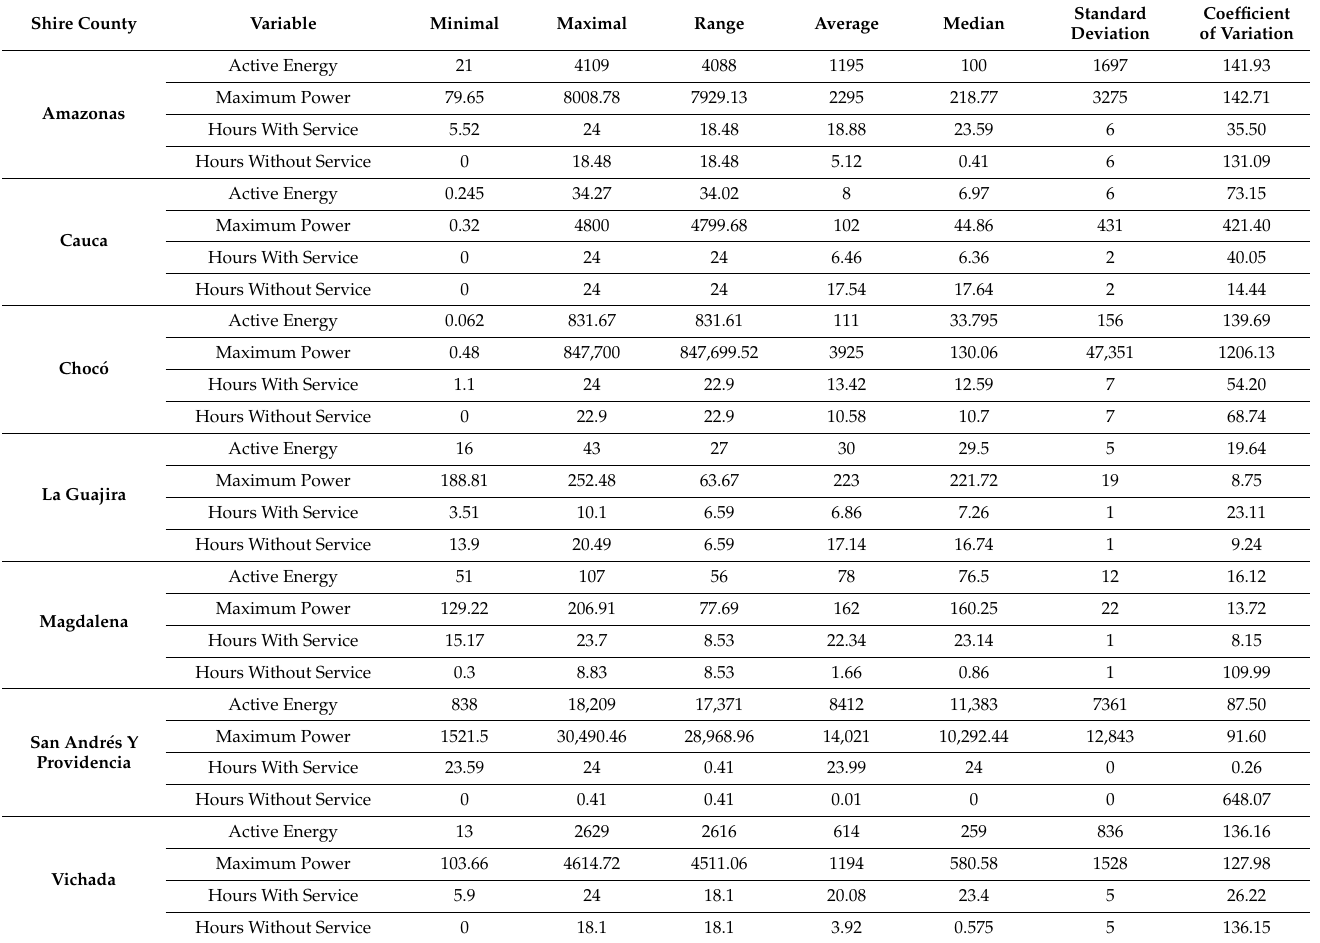
Table 2. Descriptive statistical analysis of the